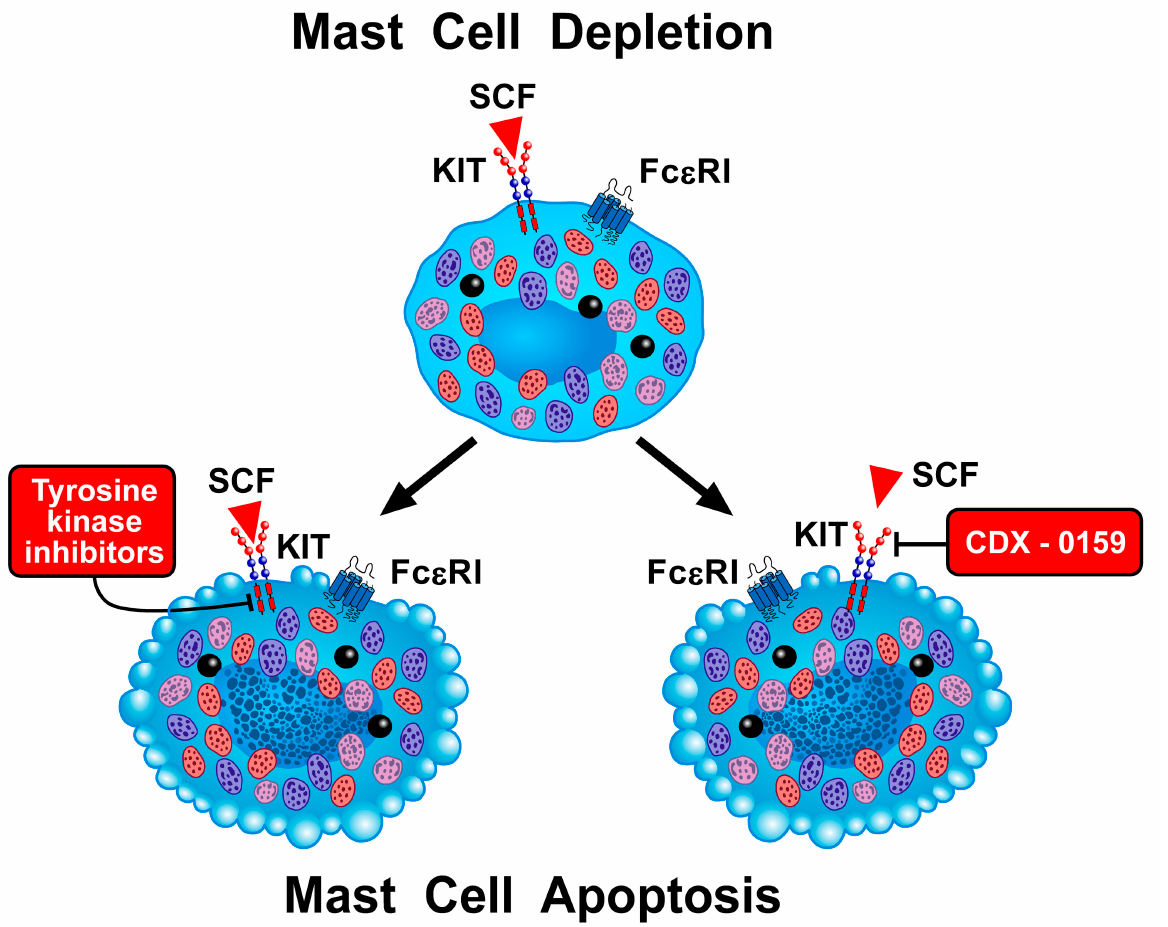
Figure 5. Schematic representation of two different strategies to deplete mast cells. Several classes of KIT-associated tyrosine kinase inhibitors (TKIs) are now available [16,260,261]. Preliminary evidence indicates that prolonged administration of imatinib [262] and masitinib [263,264] can influence airway hyperresponsiveness or reduce asthma exacerbations in asthma patients. These beneficial effects have been tentatively attributed to the inhibition of mast cell activation and/or depletion of mast cells. Another approach to induce mast cell apoptosis is through blockage of SCF-KIT interaction. CDX-0159 is a mAb that targets the extracellular dimerization domain of KIT [258,259] and causes a marked reduction of peripheral blood tryptase, suggesting systemic mast cell depletion (NCT04146129). Another approach to block KIT signaling in mast cells is to use specific tyrosine kinase inhibitors (TKIs) (Figure 5). There are several classes of KIT-targeting TKIs, which display distinct pharmacologic characteristics on human mast cells in vitro [260]. KIT- disorders [265–268]. There are very preliminary data on the in vivo efficacy of KIT-specific or multitargeted TKIs in the treatment of patients with severe allergic disorders (e.g., severe asthma). The administration of masitinib to patients with severe glucocorticoid-dependent asthma was associated with steroid-sparing effects [264]. Imatinib did not influence lung function. In another study, imatinib reduced airway hyperresponsiveness in patients with severe asthma compared to controls